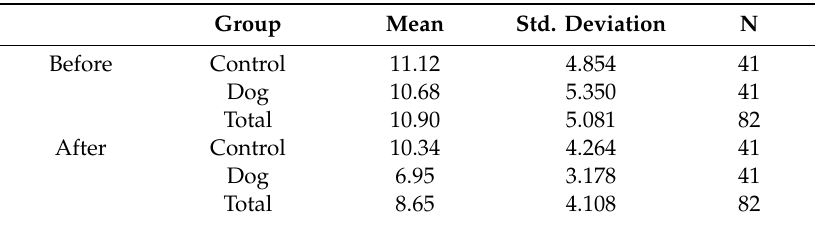
Table 3. Descriptive Statistics: